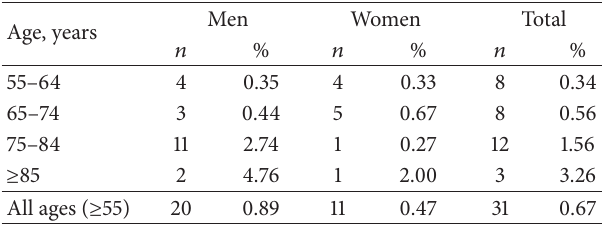
Table 2: Age-specific and sex-specific prevalence of Parkinson’s